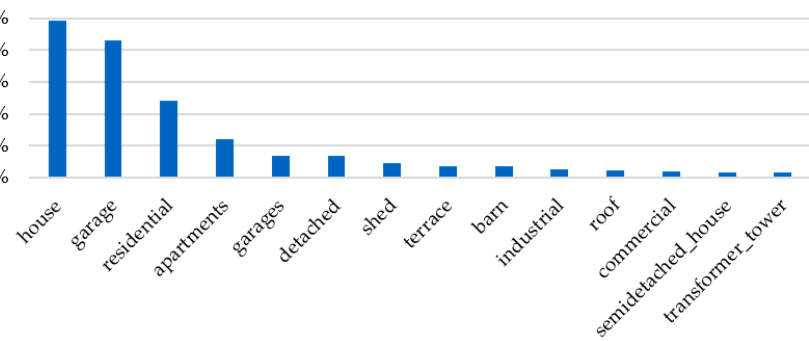
Figure 10. Relative Frequency of OSM building labels in Bavaria based on 5 Mio. Labels, excluding building type “yes”.